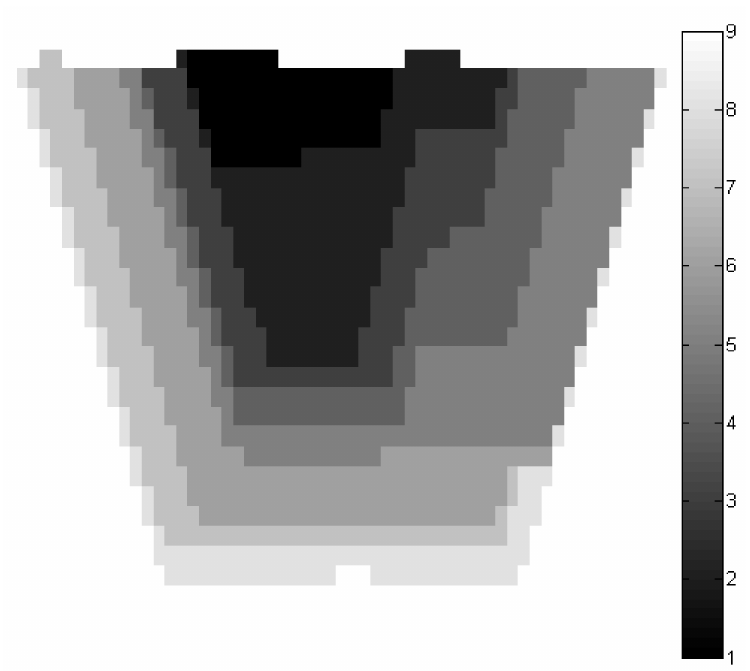
Figure 1. East–West Section of the production schedule of the study mine using the proposed approach (color bar represents production period in